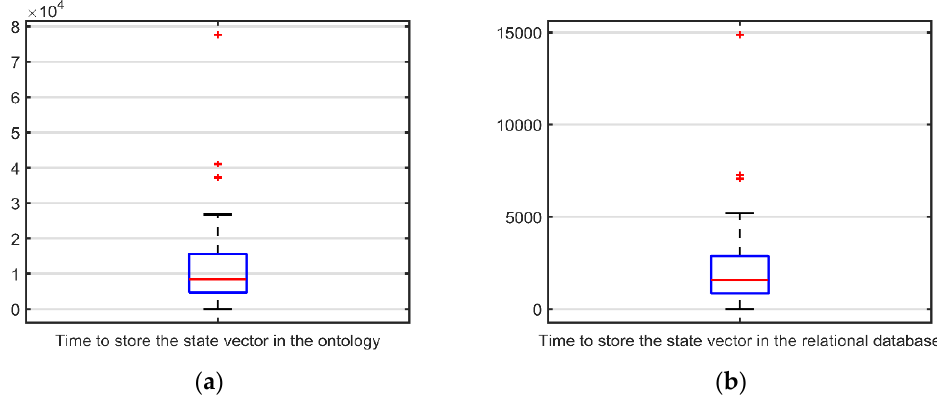
Figure 36. ( a ) Boxplot for times required to store the state vector in the SWARMs ontology; ( b ) boxplot for the times required to store the state vector in the historical database.